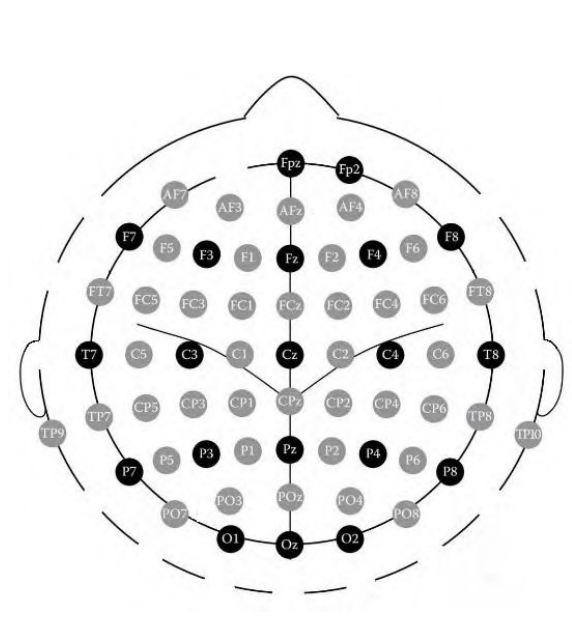
FCz is used as a reference when recording online, and the global average reference is re-referenced when